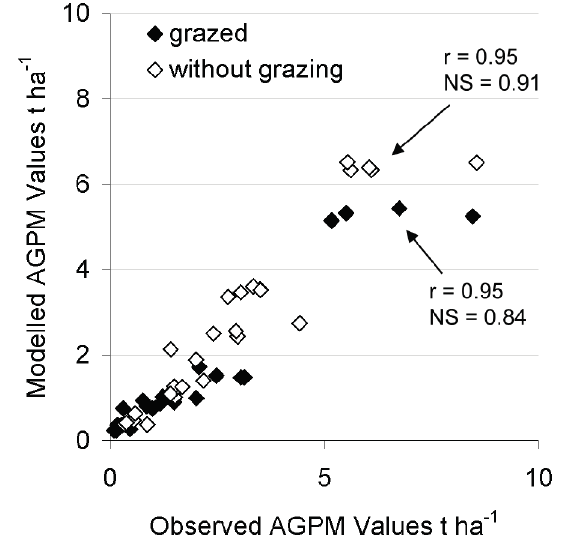
Figure 4. Validation of simulated above ground plant material (AGPM) for all measurement sites through comparison with observed values (between 2002 and 2009) under observed climate; r: coefficient of correlation; NS: Nash Sutcliffe